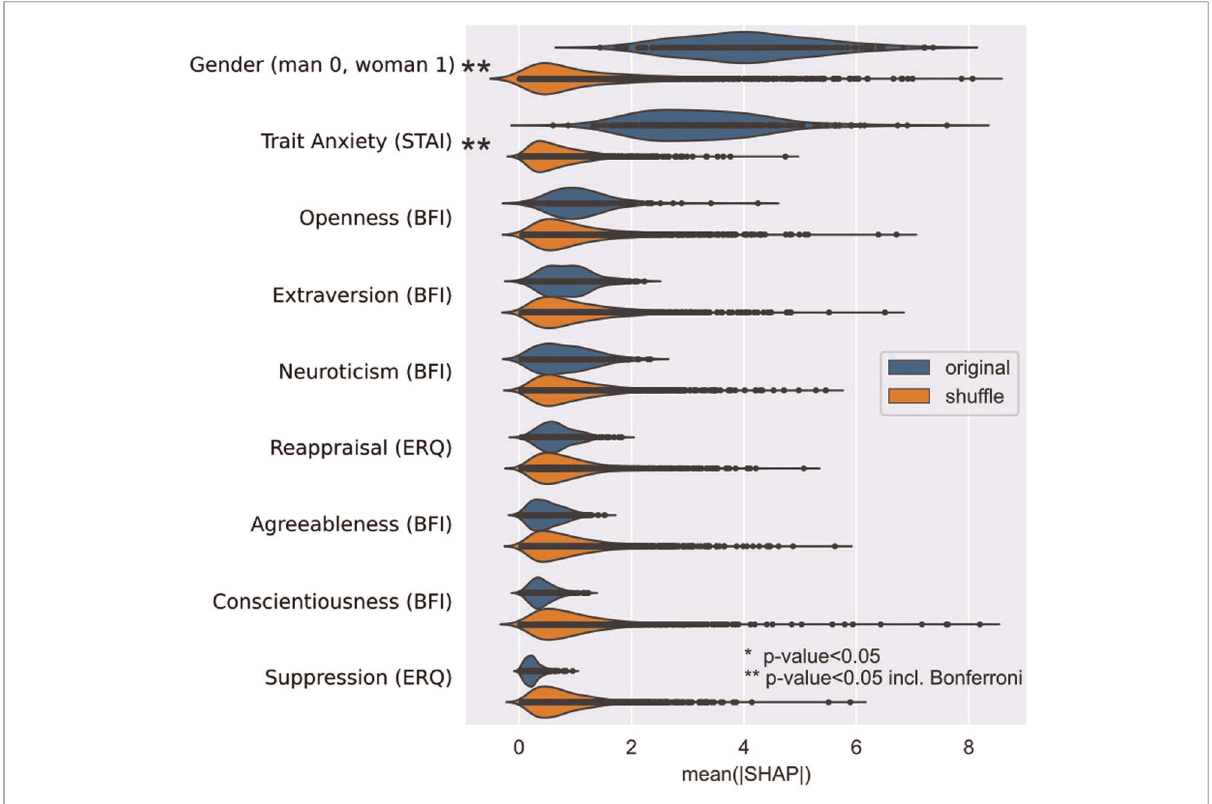
FIGURE 2 Importance of factors for the prediction of internality vs. externality control belief (FKK_skpc) when using an extra trees (ET)